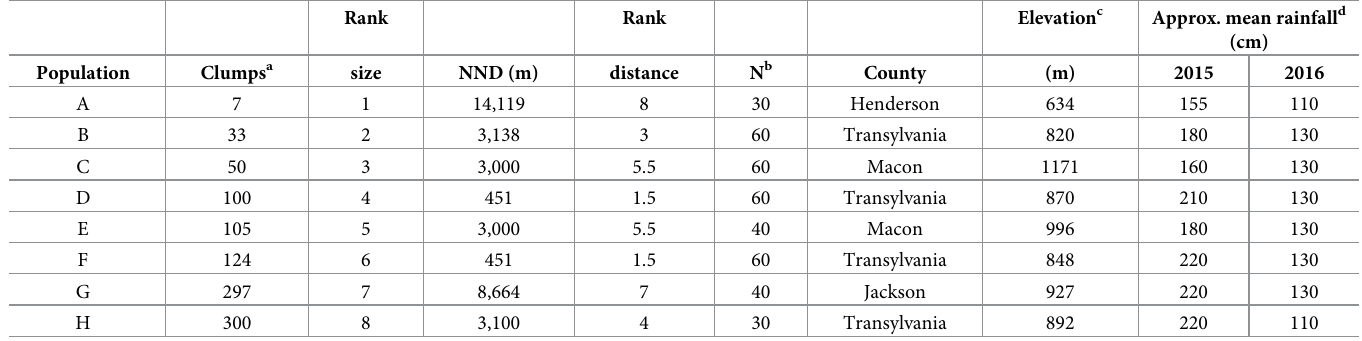
Table 1. Population size, distance to nearest neighboring population, and location data for eight s . purpurea var. montana populations in Western North Carolina.